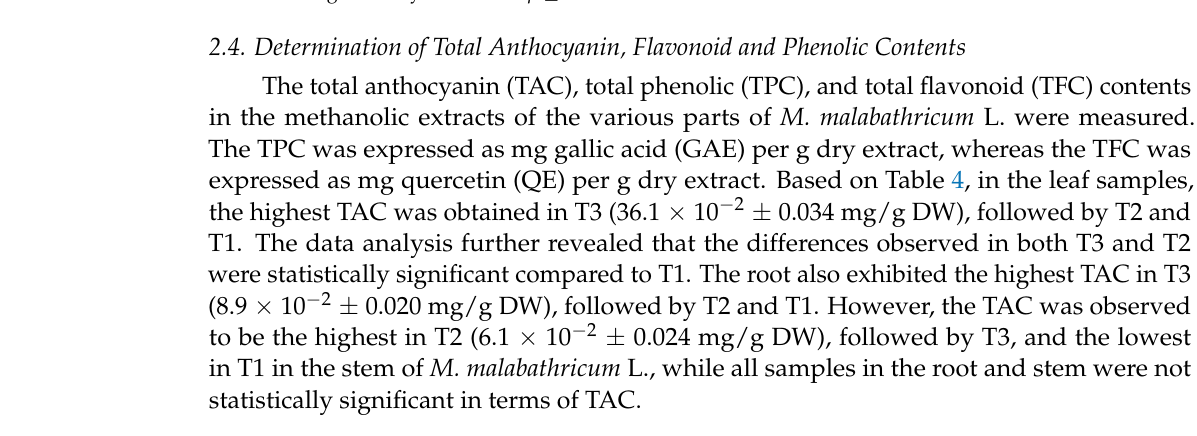
Notes: (+++) indicates appreciable amount of phytochemical; (++) indicate moderate amount of phytochemical; (+) indicate trace amount of phytochemical and (-) indicates the absence of the phytochemical. 2.3. Determination of Total Chlorophyll and Carotenoid Content